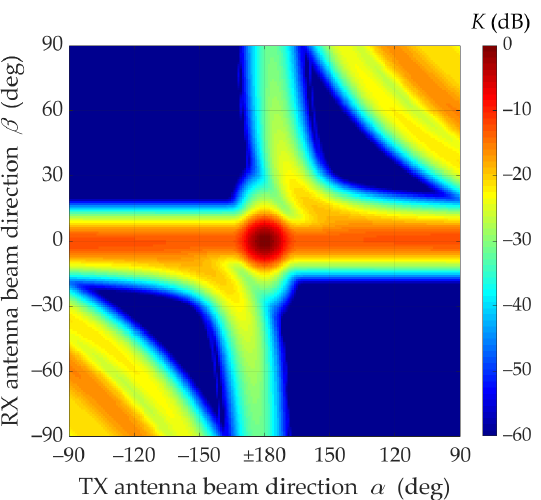
Figure 3. Relative power factor K ( α , β ) versus α and β directions of transmitting and receiving beams under LOS conditions (2D graph).